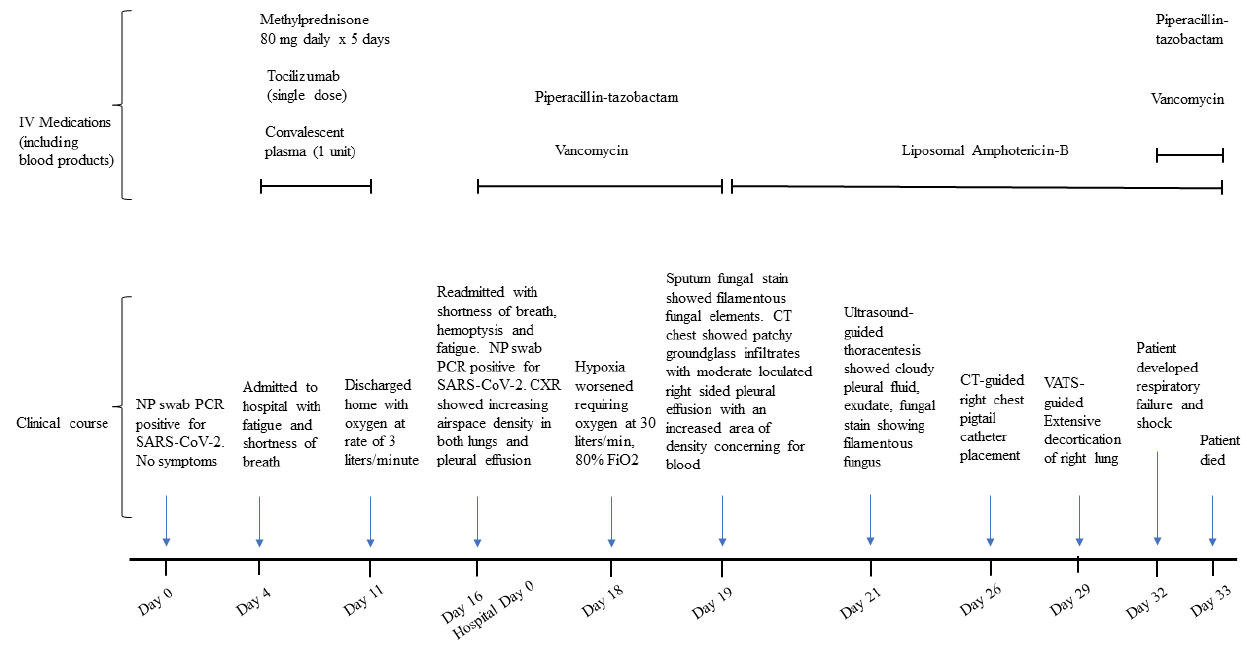
Figure 1. Clinical course of a patient with COVID-19 who developed pulmonary